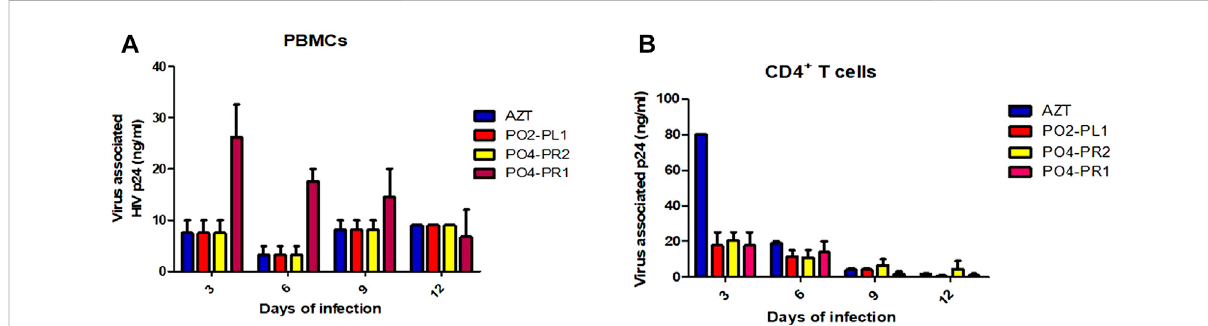
FIGURE 4 Anti-HIV activity of crude extracts of A. alternata PO4PR1, PO4PR2, and PO2PL1 as determined by p24 enzyme-linked immunosorbent assay (ELISA). A.alternata PO4-PR1andPO4PR2wereisolatedfrom Hypoxis spp.rootand A.alternata PO2PL1isolatedfrom S.birrea ’ sleaves.Theeffectof the crude extracts (100 μ g/mL) on HIV-1 replication was determined by infecting (A) PBMCs with HIV-1 NL4.3 in the presence of test crude extracts and (B) CD4 + T cells with HIV-1 NL4.3 in the presence of test crude extracts. AZT (positive control) was included at 100 μ g/mL, A.